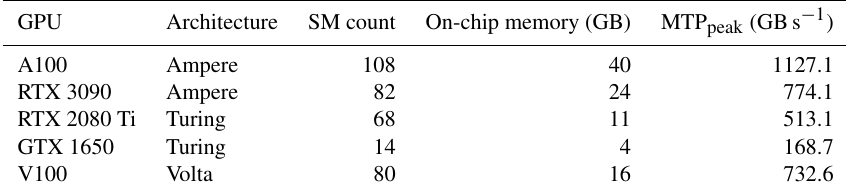
Table 1. List of the graphical processing units (GPUs) used throughout this study. We also report the peak memory throughput, i.e. MTP peak , measured thanks to the routine bandwidthTest.cu provided by Nvidia alongside with the CUDA toolkit. When compared with the effective memory throughput MTP eff , one can estimate the possible gain of an additional optimization of the algorithm. This is particularly useful when estimating the level of optimization of a GPU-based implementation.